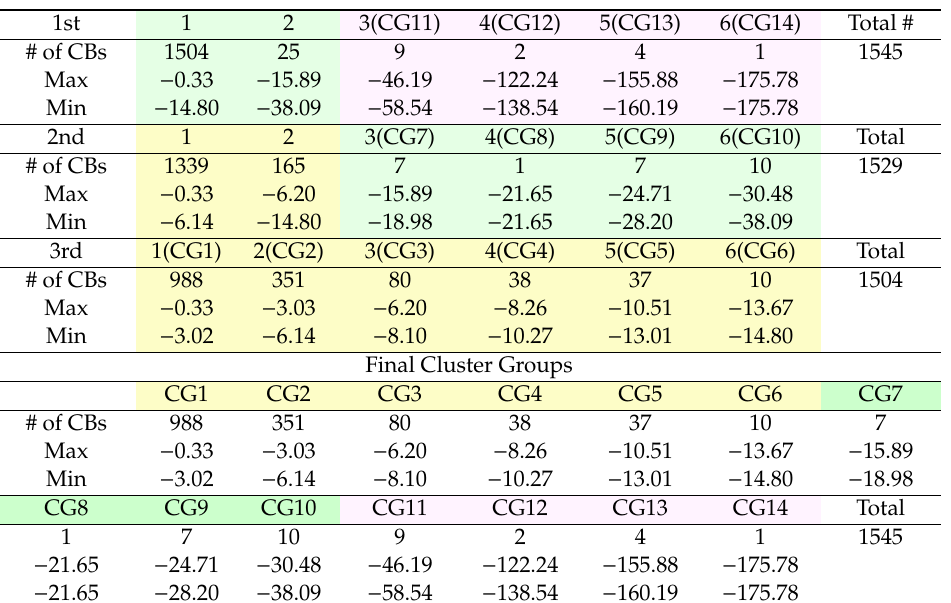
Table 3. The 14 groups via three-stage cluster analysis. Max and Min denote the maximum and minimum, respectively, of the 10 × standardized credit risk price spreads (S-CRiPSs) in each cluster. Cluster groups are formed by the three-stage centroid cluster method, first stage in red, second stage in green and third stage in